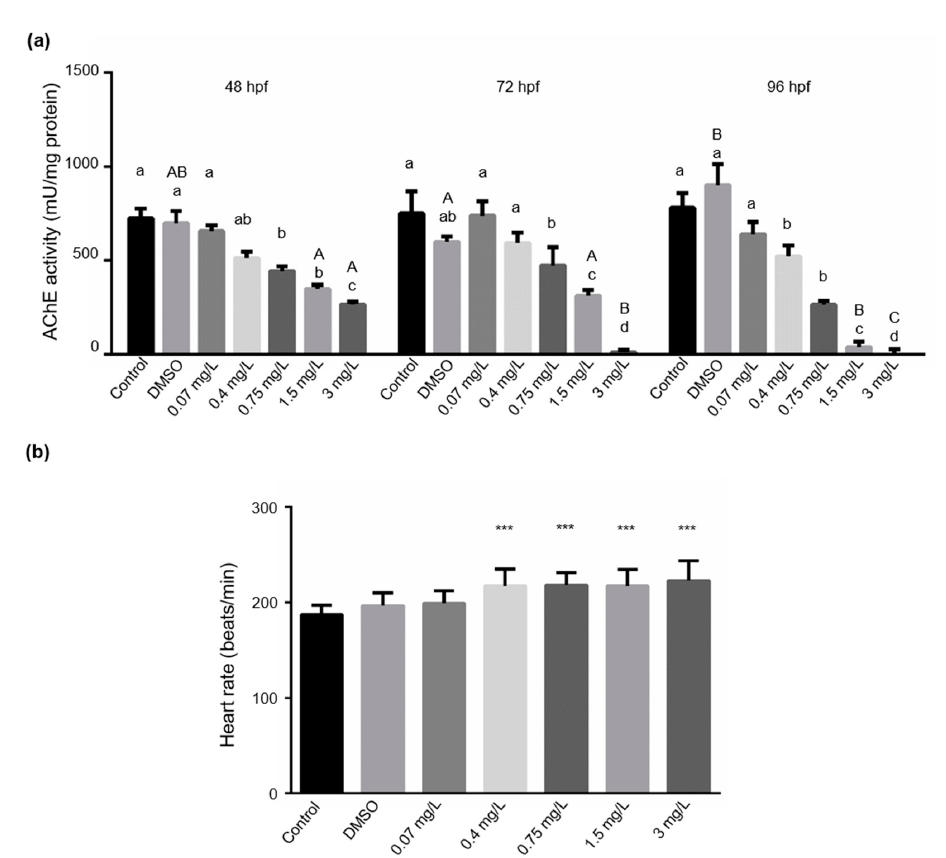
Figure 3. ( a ) Effects of bendiocarb exposure on AChE activity at 48, 72, and 96-hpf. Different lower-case letters indicate significant differences between concentrations within each time point (One-way ANOVA followed by post-hoc Tukey’s test; p < 0.05, N = 42). Different upper-case letters indicate significant differences between time points within each concentration (Tukey-test after one-way ANOVA; p < 0.05). ( b ) The average heart rate of zebrafish exposed to various bendiocarb concentrations in a 48- h test. Data represent the mean ± SD of two repeated tests. Asterisks represent significant differences to control values (determined by Tukey-test after one-way ANOVA; * p < 0.05, ** p < 0.01, and *** p < 0.001).